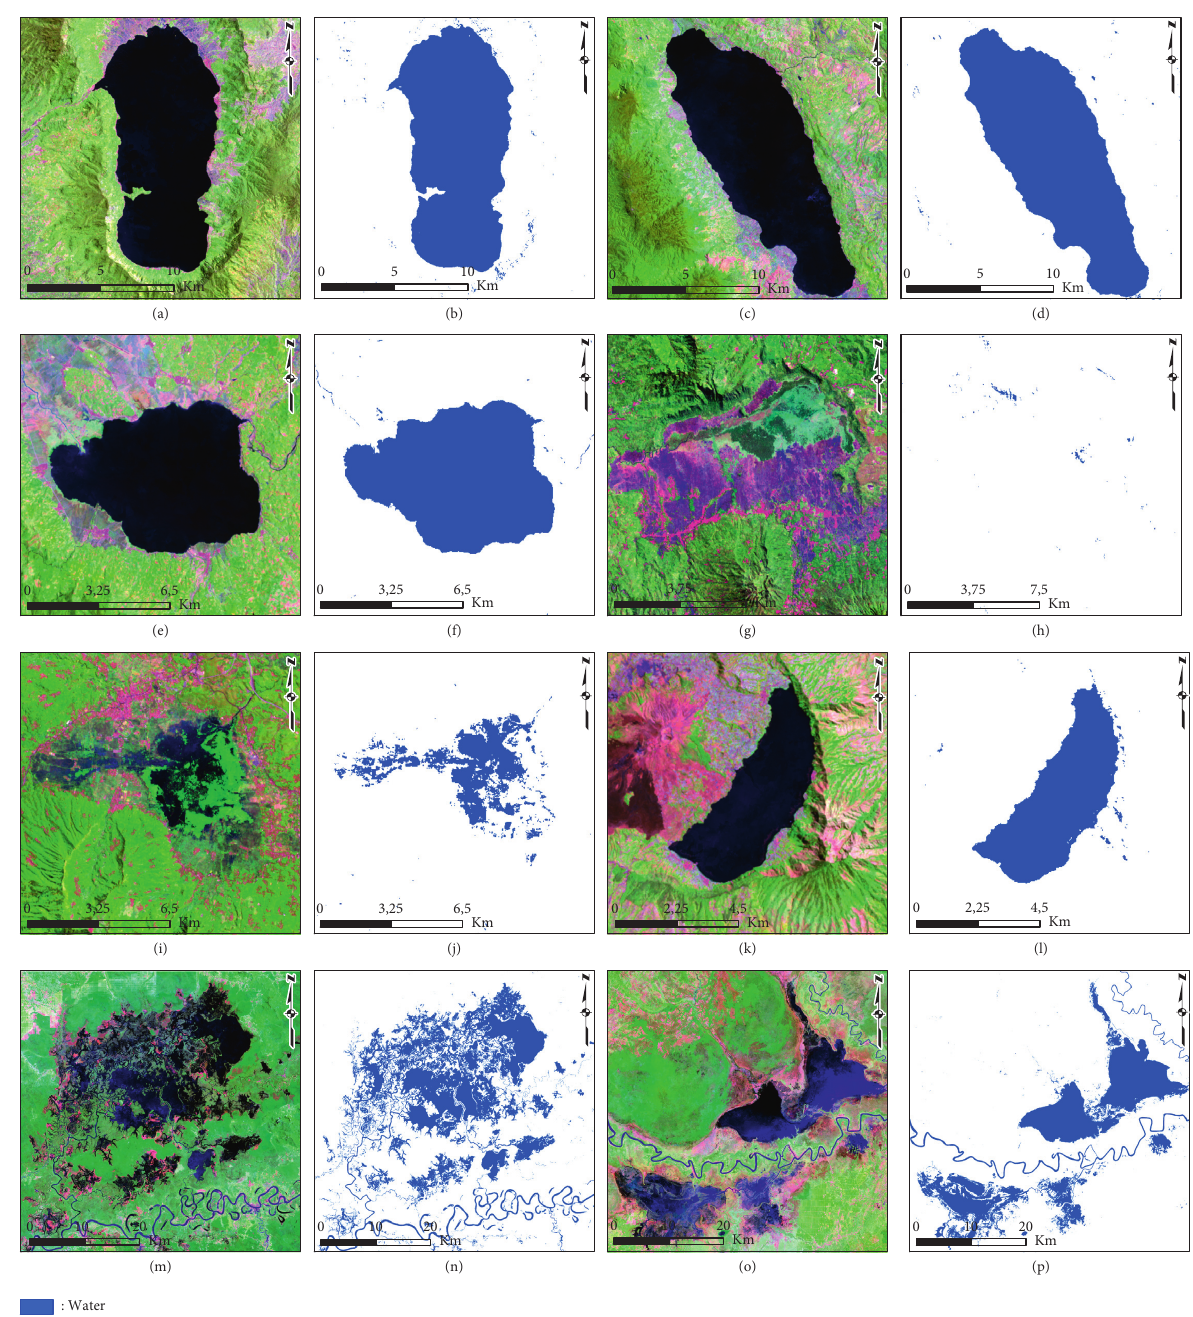
Figure 11: Results of water and nonwater classification based on the natural break threshold (AWEI ≥ − 0.232): (a, b) Maninjau Lake; (c, d) Singkarak Lake; (e, f) Kerinci Lake; (g, h) Rawa Danau; (i, j) Rawa Pening Lake; (k, l) Batur Lake; (m, n) Sentarum Lake; and (o, p) Jempang